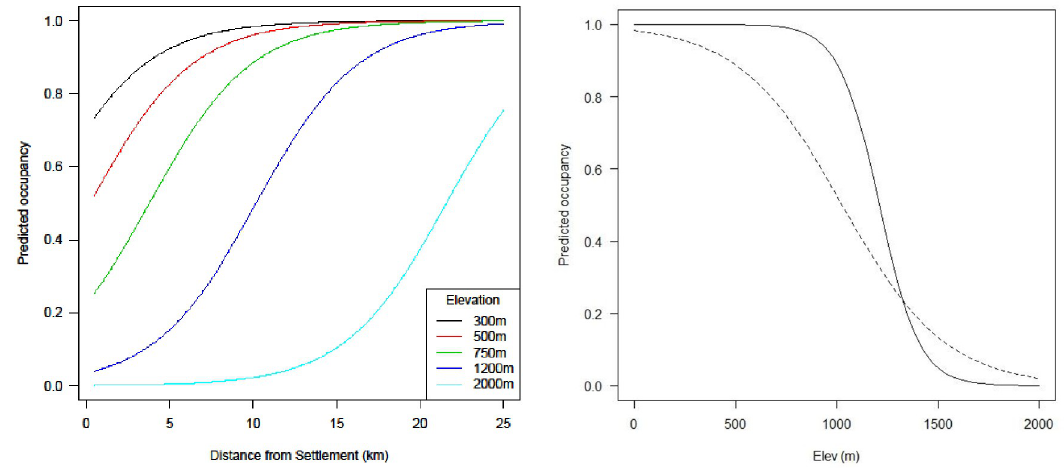
ranked occupancy models in Temengor Forest Reserve and Royal Belum State Park.